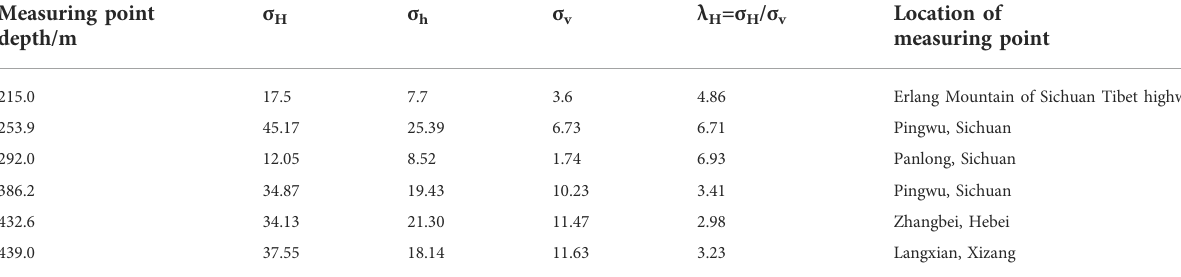
TABLE 3 Regional distribution of measured results close to the theoretical ratio